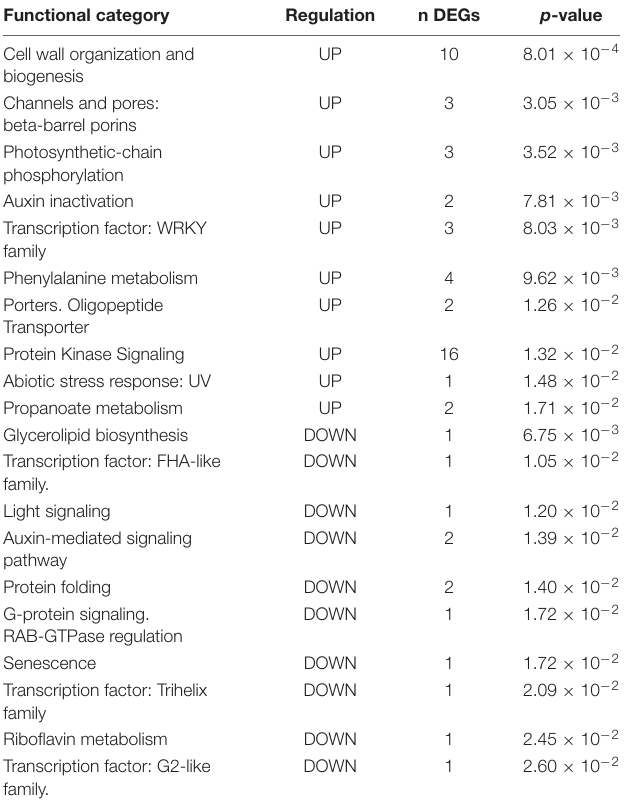
TABLE 4 | Functional enrichment in Group III. DEGs up- and down-regulated by the BCA Vintec R (cid:13) . Functional category